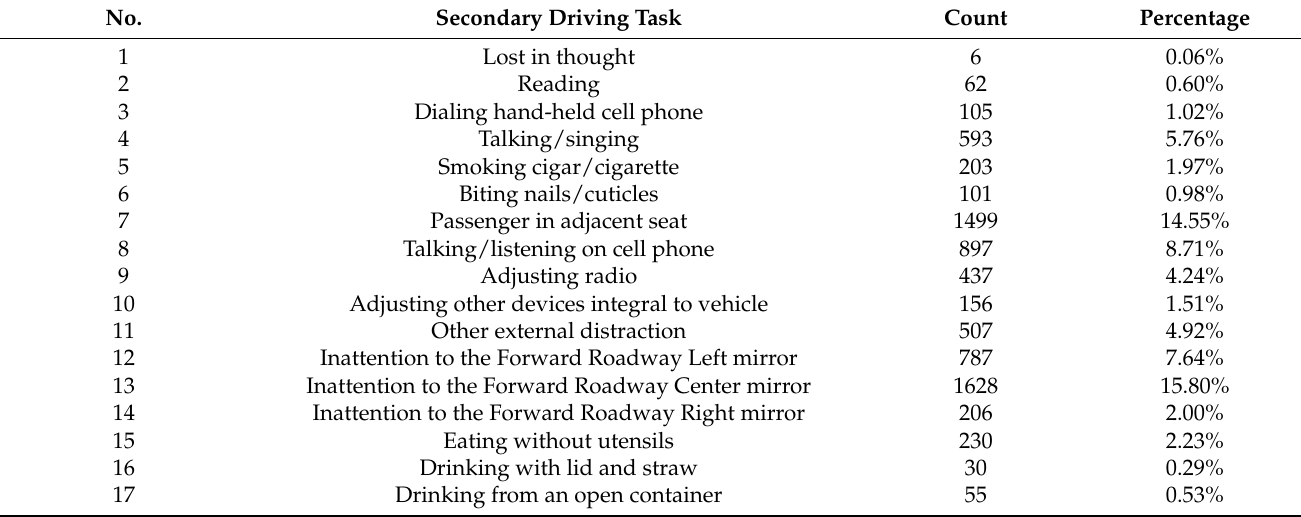
Table 2. Number of secondary driving